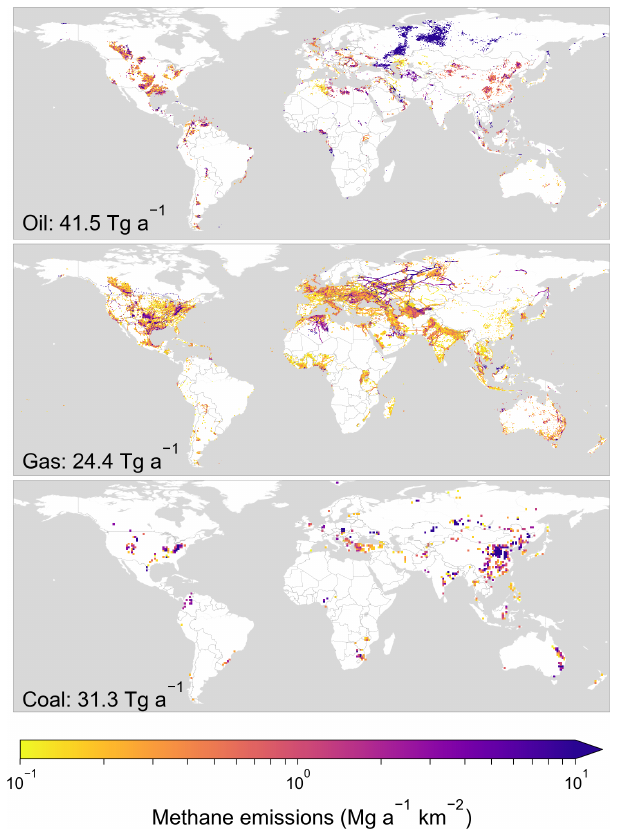
Figure 4. Global distribution of 2016 methane emissions from oil, gas, and coal in our inventory. The inventory is at 0 . 1 ◦ × 0 . 1 ◦ grid resolution but coal is shown here at 1 ◦ × 1 ◦ resolution for visibility. Emissions below 10 − 1 Mga − 1 km − 2 are not shown.